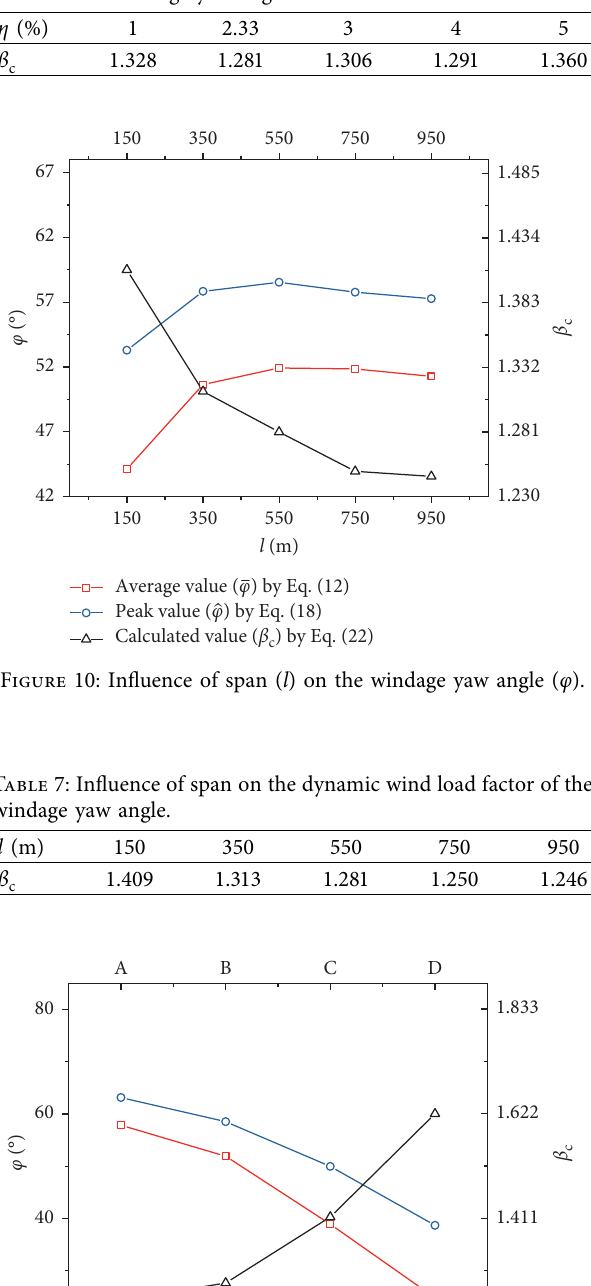
Table 6: Influence of sag-to-span ratio on the dynamic wind load factor of the windage yaw angle.